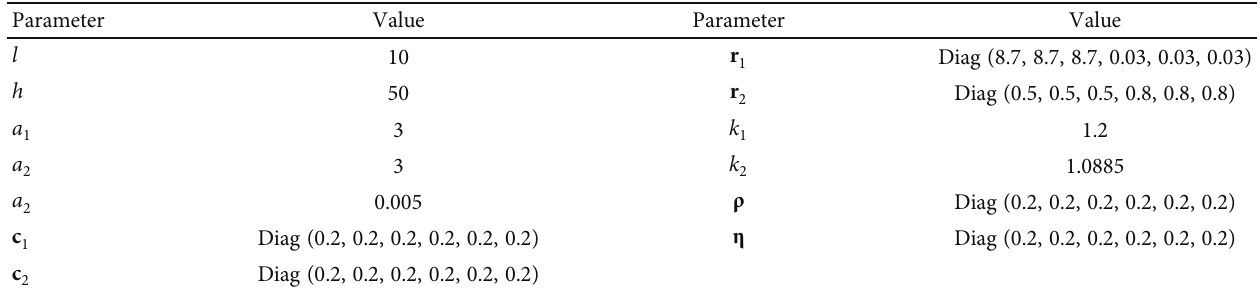
Table 1: Controller